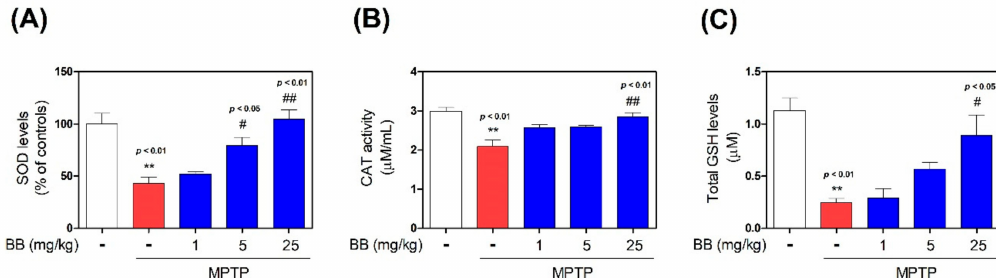
Figure 4. E ff ects of BB on MPTP-induced antioxidant enzyme levels. Levels of antioxidant enzymes such as superoxidase dismutase (SOD; A ), catalase (CAT; B ) and glutathione (GSH; C ) in SNpc were measured using ELISA kits. Values represent means ± S.E.M. ** p < 0.01 compared with the control group, and # p < 0.05 and ## p < 0.01 compared with the MPTP-treated